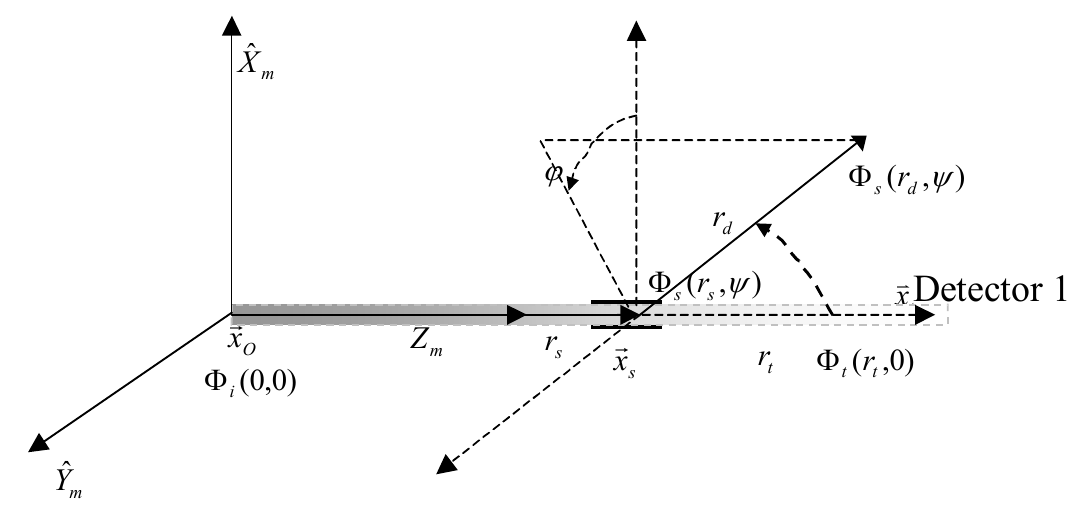
Figure 1. Measuring principle of the